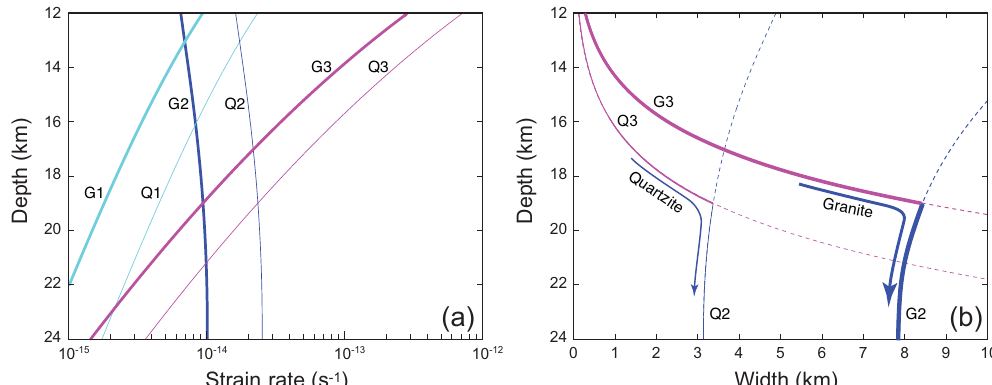
Figure 4. (a) Strain rate as a function of depth for quartzite (Q) and mylonitic granite (G), calculated using a geothermal gradient of 25 ◦ Ckm − 1 down to 12km (the depth of the BDT), and 22 ◦ Ckm − 1 below the BDT, following the stress–temperature profile for the Whipple Mountains from Behr and Platt (2011). Quartz flow laws (Q1–Q3) are from 1, Hirth et al. (2001); 2, (theoretical dislocation creep); and 3, (DRX creep) Platt and Behr (2011b). Mylonitic granite flow laws (G1–G3) were calculated assuming strain partitioning between quartz and feldspar (40% by volume) following the Reuss (constant stress) condition, based on quartz forming interconnected weak layers with flow laws 1–3 as above, and using the feldspar dislocation creep flow law from Rybacki et al. (2006). Water fugacity for all flow laws was assumed to be constant with depth at 28MPa (see text for discussion). (b) Shear zone width as a function of depth for quartzite and mylonitic granite for a slip rate of 5mmyr − 1 , assuming that the fastest flow law dominates the deformation. Shear zone width increases down to a depth of ∼ 19km, at which point the mechanism in quartz switches from DRX creep to climb-assisted dislocation creep, with no further increase in width. Note that most other published flow laws for quartz predict much lower strain rates, and hence much greater shear zone widths, under these